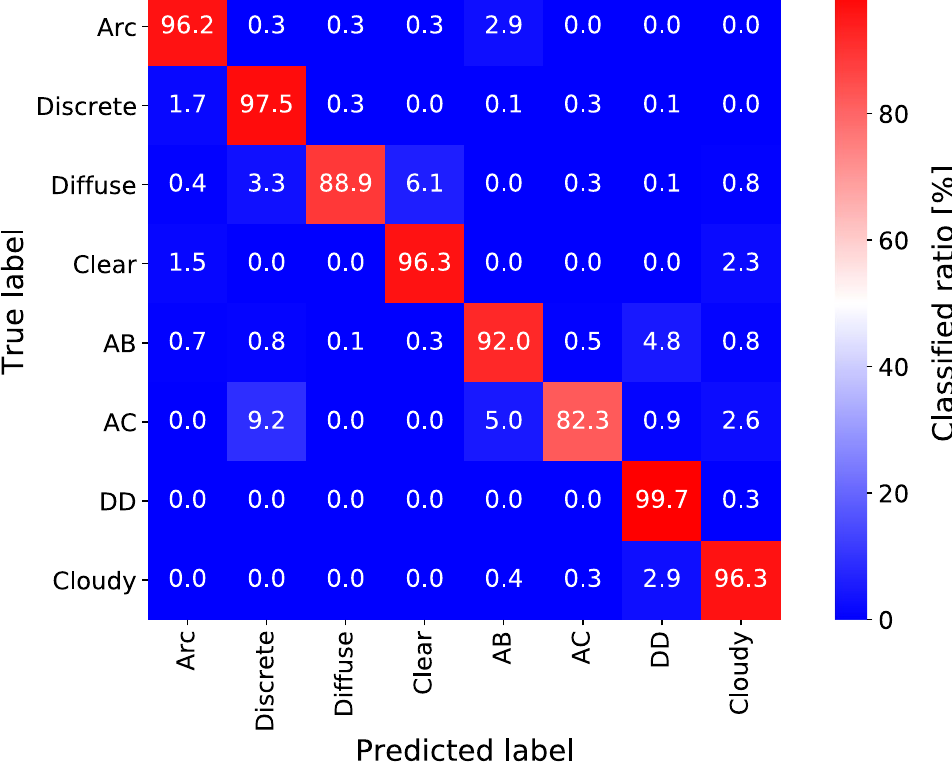
eventually created images in the same format as that shown in Fig. 3 for all observation dates over 10 years, and visually confirmed that the classification results were correct to the same level as that demonstrated in Fig. 3. Variations of auroral occurrence. Figure 4 shows the distribution of the auroral occurrence rate as a function of month and year over 10 years. The vertical axis is the month and the horizontal axis is the year of optical season, i.e., from September to March in the next year. Again, the auroral occurrence rate is defined as the number of the Auroral images divided by that of the Observable images. Each square panel filled with colors indicates the occurrence rate, the number of the Auroral images, and that of the Observable images. While the number of images varies widely from month to month, as it is affected by the length of cloudy periods and the temporal resolution, the occurrence rate is less affected by these factors. In September 2014 and 2018, where the numbers are unavailable, the camera was not operative due to the delay in starting the observation. Throughout the decade, the panel is mostly bluish from November to January, indicating a lower auroral occurrence rate. To make it easier to observe this tendency, we have added the right panel, which shows the monthly variation of the occurrence rate derived by summing the numbers over the decade. The panel clearly demonstrates the decreas- ing trend of auroral occurrence in the winter solstice. Furthermore, it was found that there was no significant dif- ference between the auroral occurrence rate in the autumn and spring equinoxes and that the graph was nearly lined symmetrical with respect to December. The same method was applied to plot the upper panel, which shows the annual variation of the auroral occurrence rate. It did not peak in the 2013 season, which was when the sun- spot number reached its maximum during solar cycle 24, but instead, in the 2015 season, which corresponds to the early declining phase of the solar cycle. On the other hand, the auroral occurrence rate attained its minimum during the 2019 season, which was when the sunspot number reached its minimum. Since all the images used in this study were captured in Tromsø, it is likely that local parameters representing the level of geomagnetic disturbances, such as the K-index, rather than macroscopic/global parameters, such as the sunspot number, would correlate well with the auroral occurrence rate. The K-index represents the geo- magnetic disturbance in a 10-point scale (0–9) with a three-hour resolution; the higher the K-index, the more likely it is for an aurora to appear. Figure 5 shows the annual variation of the auroral occurrence rate shown in Fig. 4 and the ratio of time when the K-index was above 4 during a local night in Tromsø, i.e., 15–03 UT. Note that only days with more than 100 Observable images were included in the calculation. The blue and red lines attained their minimums in the 2012 and 2019 seasons, respectively, and a maximum in the 2015 season,